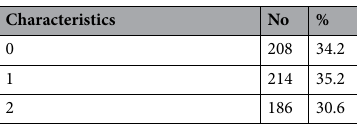
Table 1. Patient and tumour characteristics. BMI Body Mass Index, ASA score American Society of Anesthesiologists score, SII Systemic immune-inflammation index, F-SII Fibrinogen and systemic immune- inflammation index.